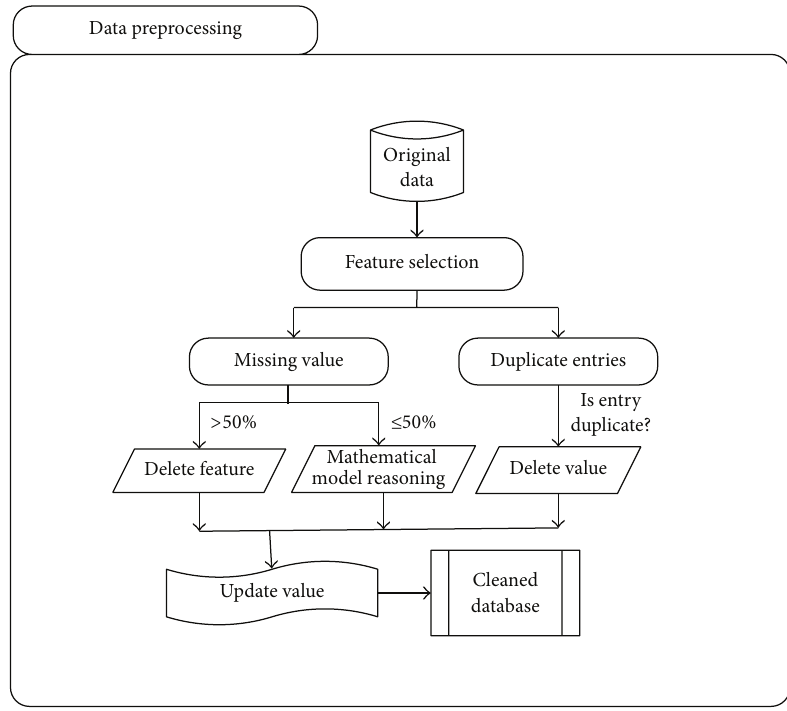
Figure 2: Flow diagram for handling data redundancy.